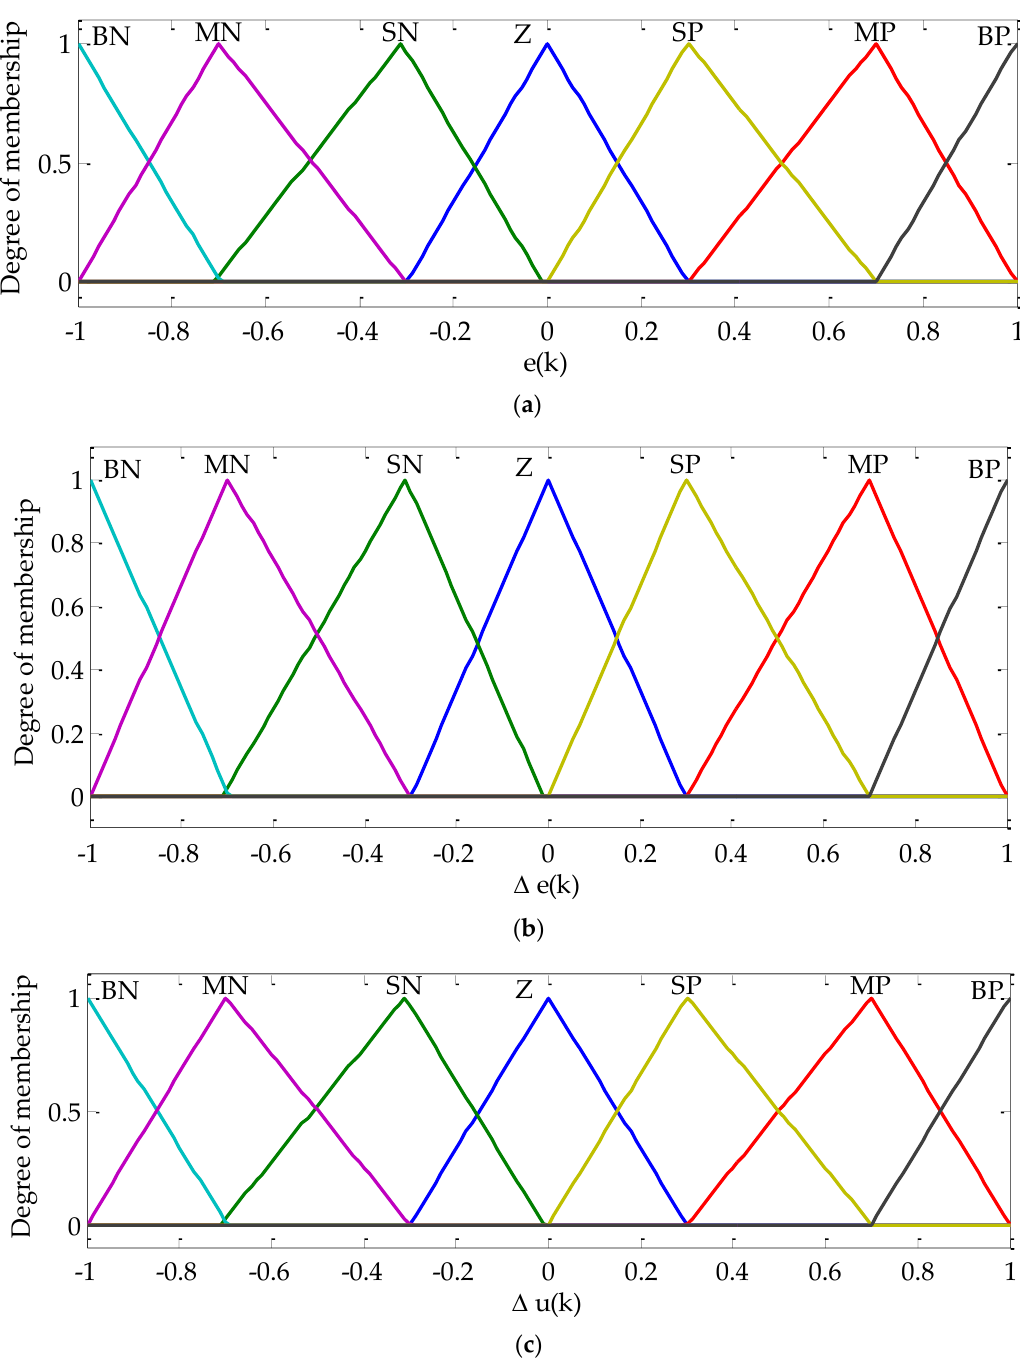
Figure 8. Fuzzy logic MPPT algorithm membership functions: ( a ) Error membership function, ( b ) Change error membership function, and ( c ) change duty cycle membership function. Table 1. Rule-based table of the fuzzy logic MPPT algorithm.